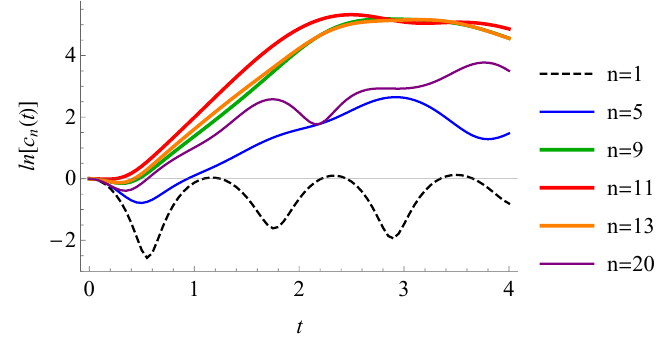
Figure 2 . The microcanonical OTOCs for the IHO. We can see the strong exponential growth for intermediate modes (like n = 9 ∼ 13 ), while lower modes and higher modes do not show initial exponential growth. The energy range of these intermediate modes correspond to the local maximum of the potential (the red lines in figure 1(a)).